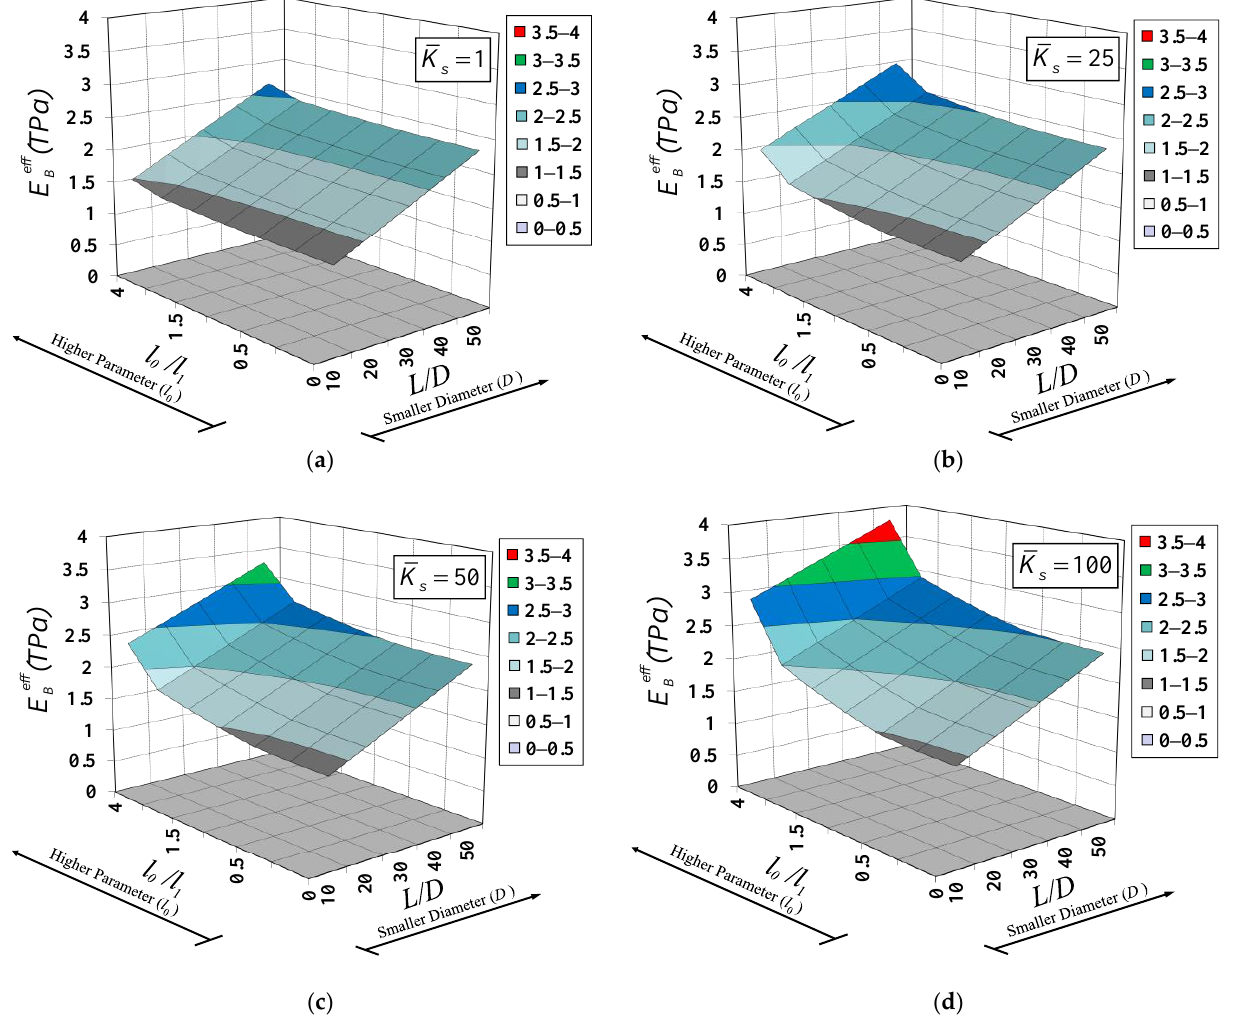
Figure 7. Variation of effective Young’s modulus with SWCNT diameter and material length-scale parameter for various elastic substrate stiffness: ( a ) K s = 1, ( b ) K s = 25, ( c ) K s = 50, and ( d ) K s =